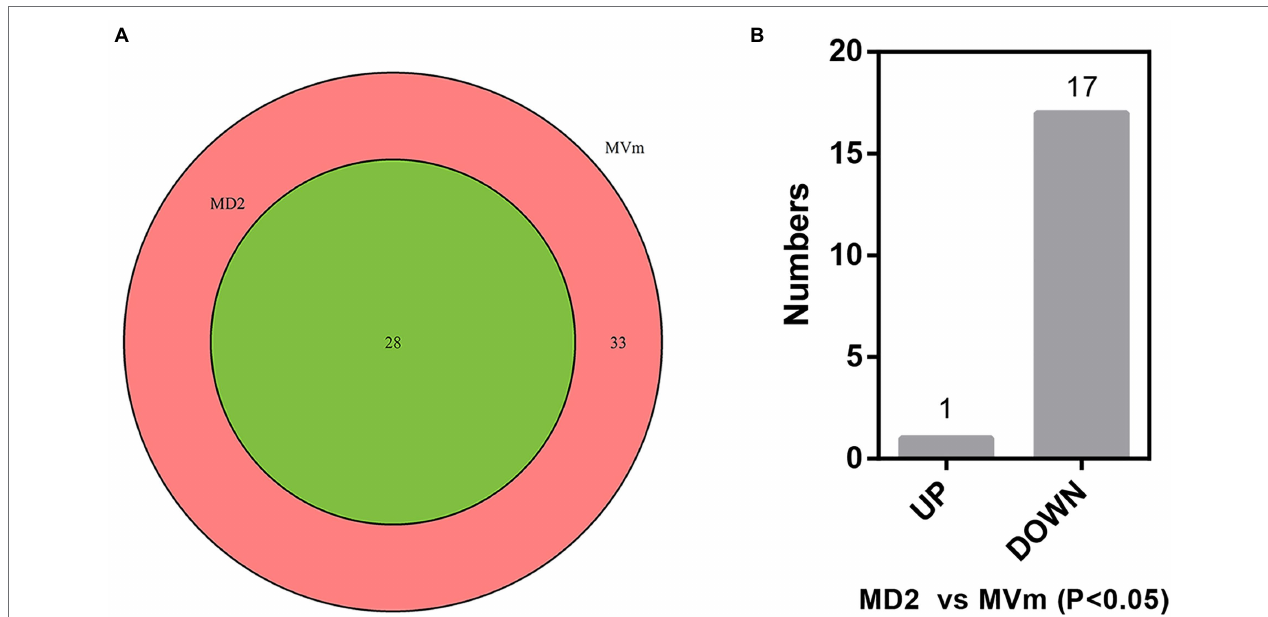
FIGURE 1 | (A) Venn diagrams of detected miRNA-like RNAs (milRNAs). (B) The bar plot of differentially expressed milRNAs in the MD2 and MVm (P < 0.05). MD2: Δ Vm - DCL2 ; MVm: WT.